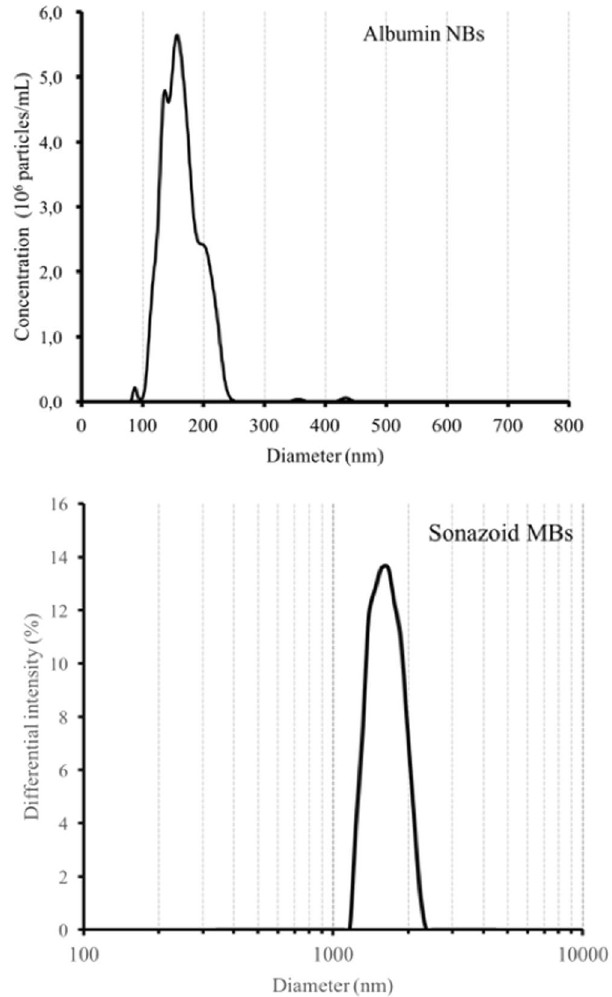
Figure 3. Measurement of bubble size for albumin NBs (top) and Sonazoid MBs (bottom).